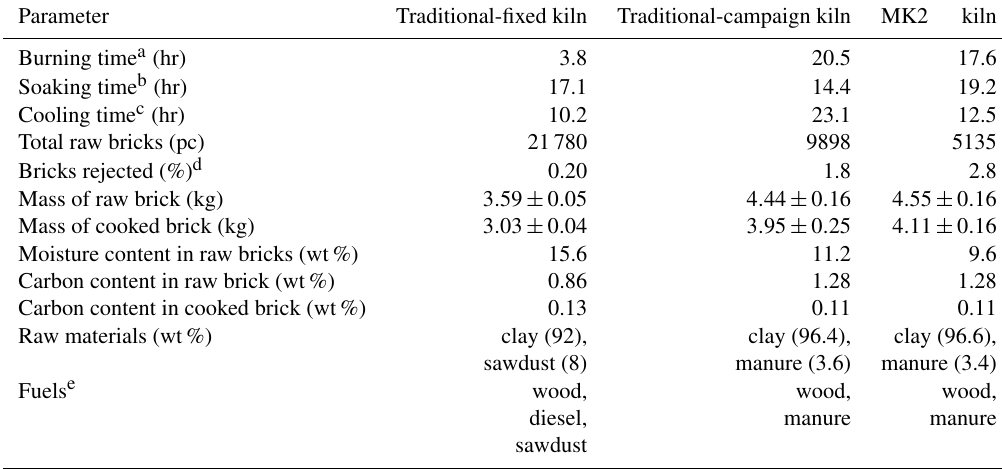
Figure 1. Brick kilns sampled: (a) MK2 kiln in El Refugio, Guanajuato; (b) traditional-campaign kiln in El Refugio, Guanajuato; and (c) traditional-fixed kiln in Abasolo, Guanajuato. Table 1. Summary of the characteristics of kilns sampled.